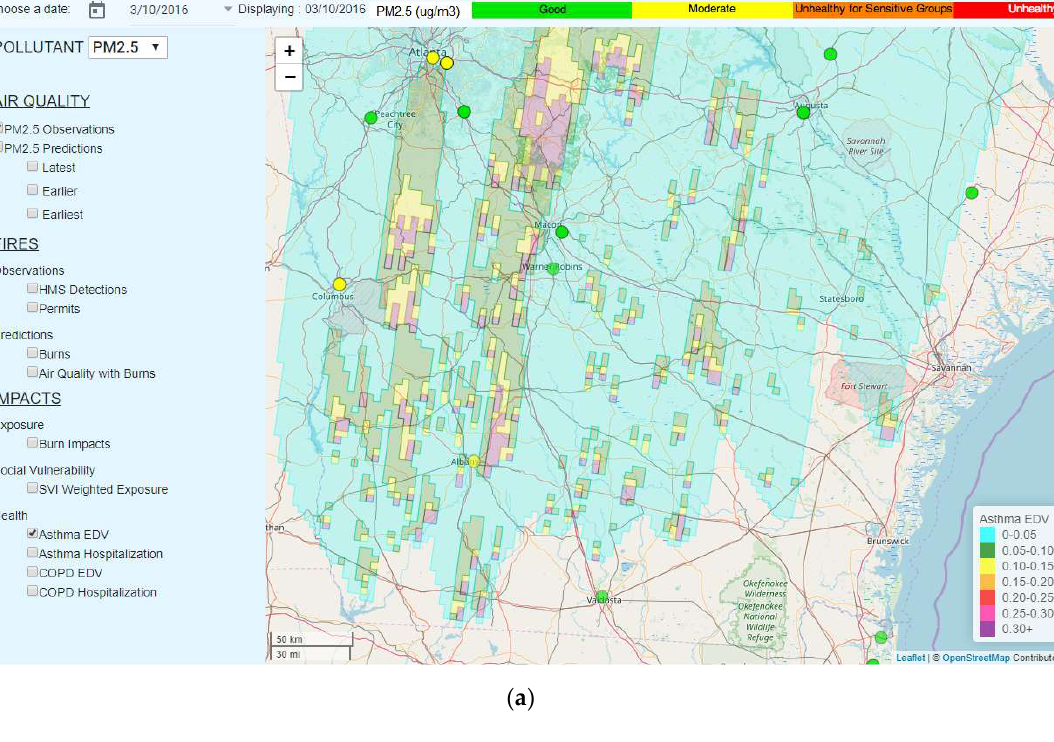
asthma or EDV, and of COPD patients due to the forecasted smoke exposure (Figure A7).